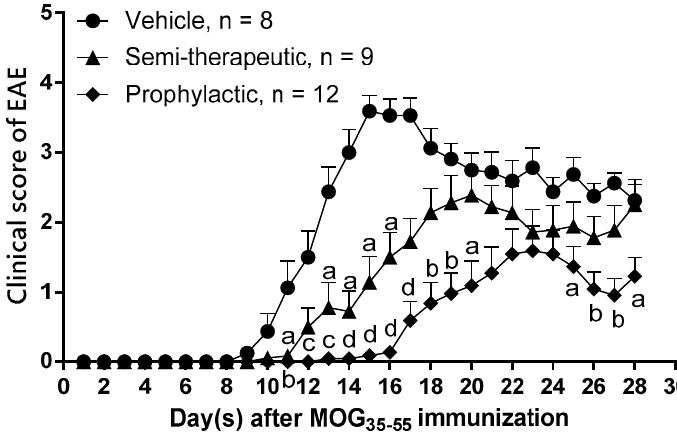
Figure 1. GLP-1 receptor agonist (GLP-1 RA) dulaglutide treatment significantly attenuates